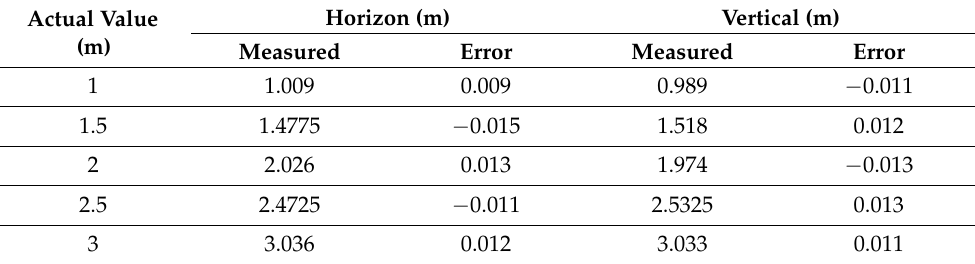
Table 5. Tag recognition performance at 200